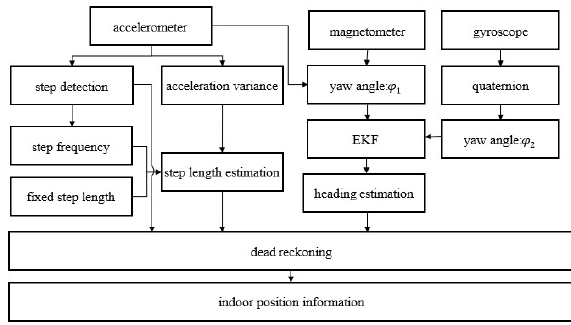
Figure 2. PDR structure frame